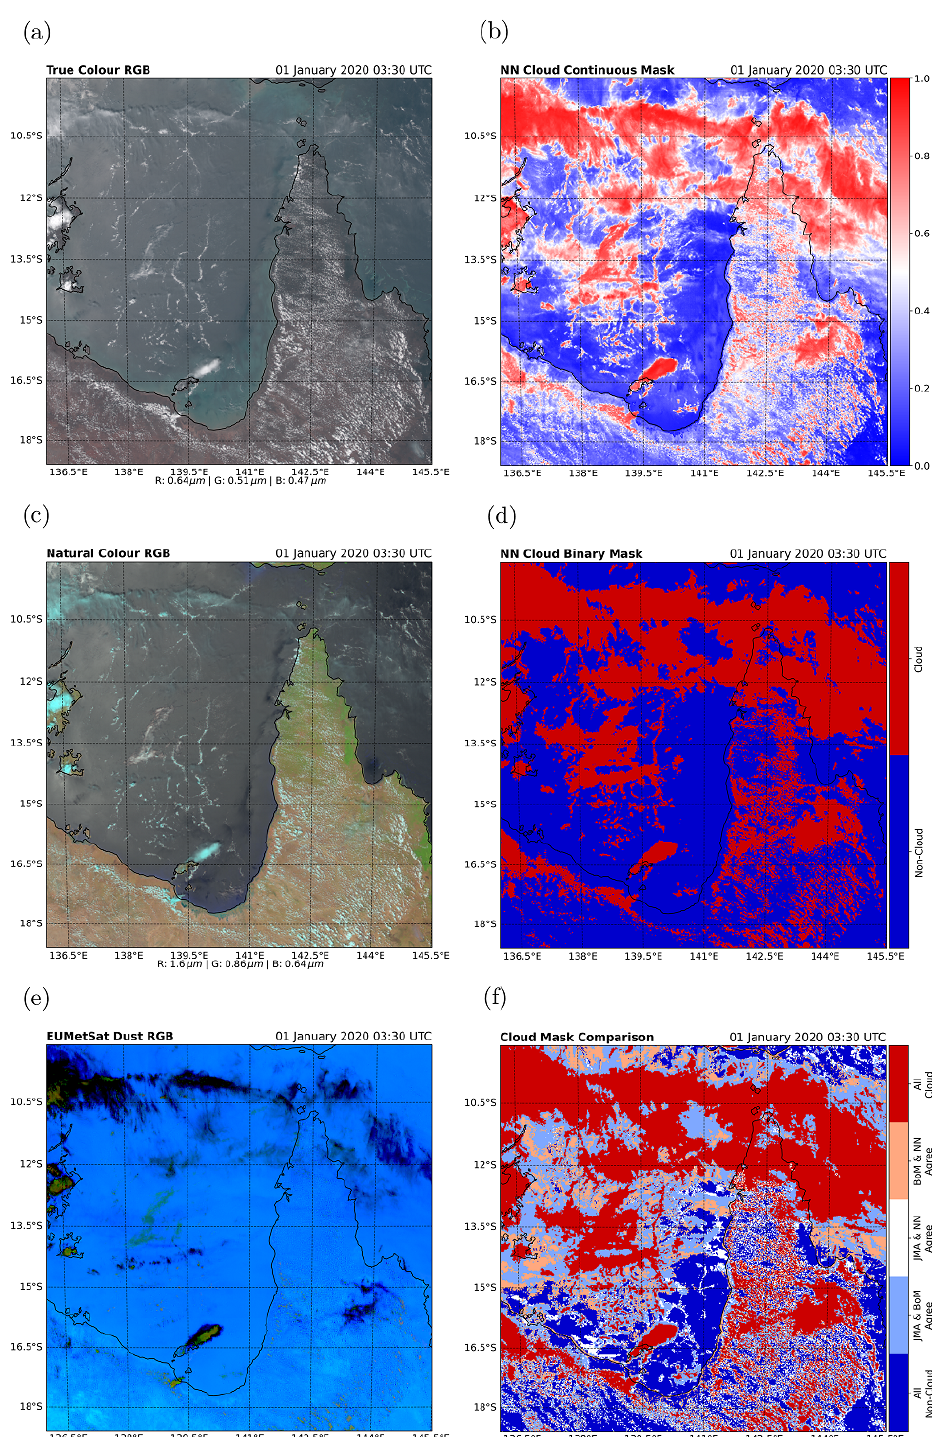
Figure 11. Case study B covering the Gulf of Carpentaria from an AHI scene for 1 January 2020 at 03:30UTC. A total of three RGB false-colour composites of the scene are presented in the left-hand column, showing (a) true-colour, (c) natural-colour and (e) dust RGBs. The top, middle and bottom panels of the right-hand column show (b) the NN continuous cloud mask, (d) NN binary cloud mask and (f) a comparison of the three binary masks for the